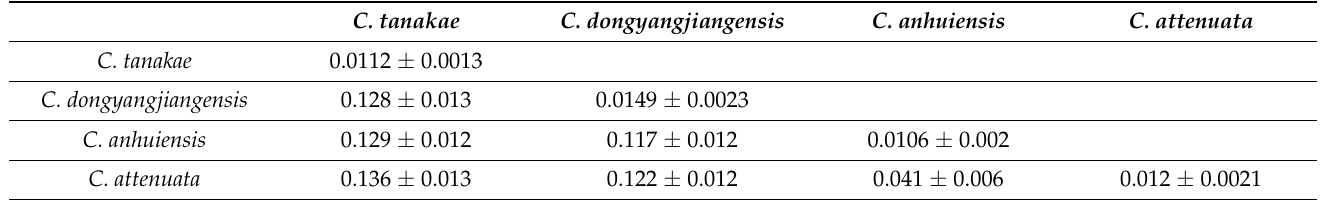
Table 1. The interspecific and intraspecific genetic distances ( p -distances) of Crocidura attenuata species complex based on mitochondrial cytochrome- b ( Cytb ) sequence